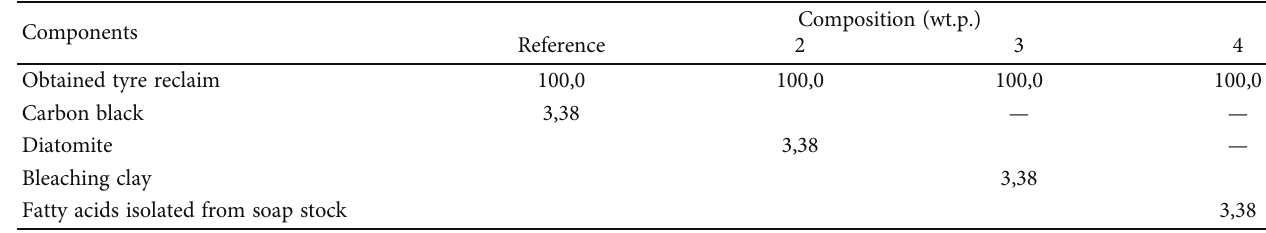
Table 2: The modi fi ed tyre reclaim composition (wt.p.).